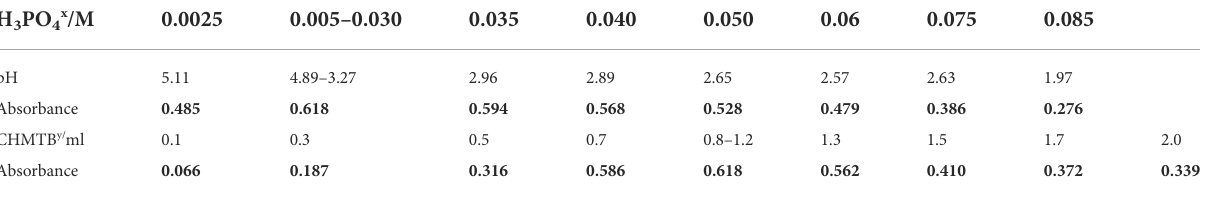
TABLE 1 Effect of physical variables on the optical density of Ir (III)-CHMTB complex H 3 PO 4 x